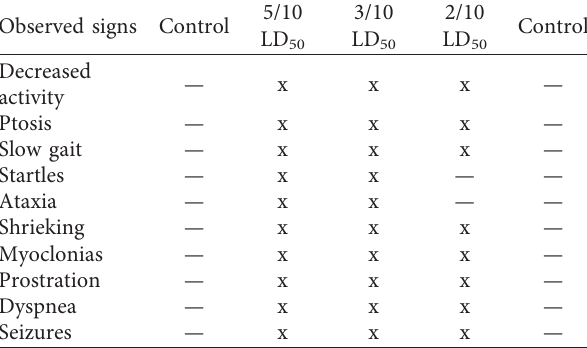
Table 2: Behavioral effect of administration of different doses of the mixture of clothianidin (Poncho ® 600) and thiacloprid (Calypso ® 480). Observed signs